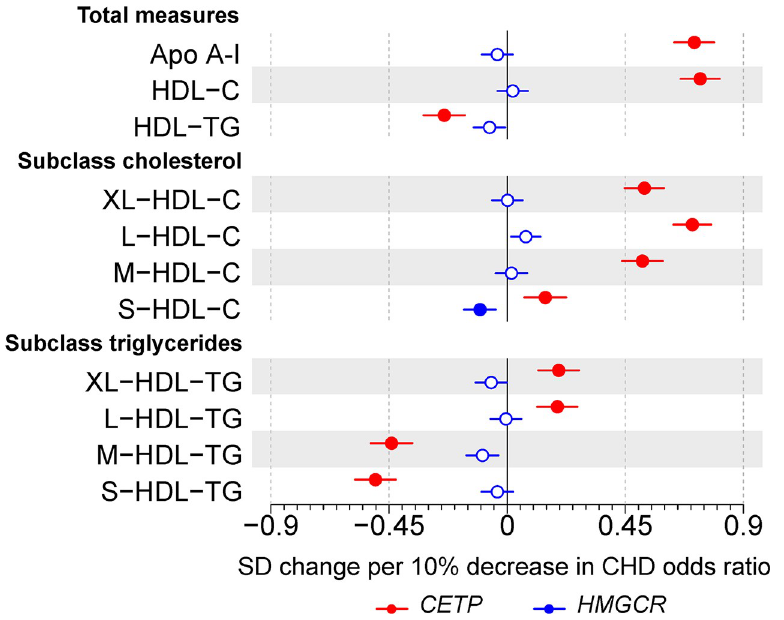
Fig 3. Associations of genetic variants in CETP rs247617 (red) and HMGCR rs12916 (blue) with circulating apolipoprotein A-I as well as cholesterol and triglyceride concentrations in size-specific HDL particles. Estimates represent the standardized difference in lipoprotein trait, with per allele associations scaled to a 10% lower relative risk of CHD. Analyses were adjusted for age, sex, genotyping batch, and 10 genetic principal components. The circles refer to the effect estimates and the horizontal bars to the 95% CIs. Closed circles represent statistical significance of associations at P < 0.002 and open circles associations that are nonsignificant at this threshold. The lipoprotein subclasses are defined by particle size [17–19]:the 4 size-specific HDL subclasses are very large (average particle diameter 14.3 nm), large (12.1 nm), medium (10.9 nm), and small HDL (8.7 nm). Underlying data can be found in S1 Data. Apo A-I, apolipoprotein A-I; C, cholesterol; CHD, coronary heart disease; HDL, high-density lipoprotein; TG, triglycerides.